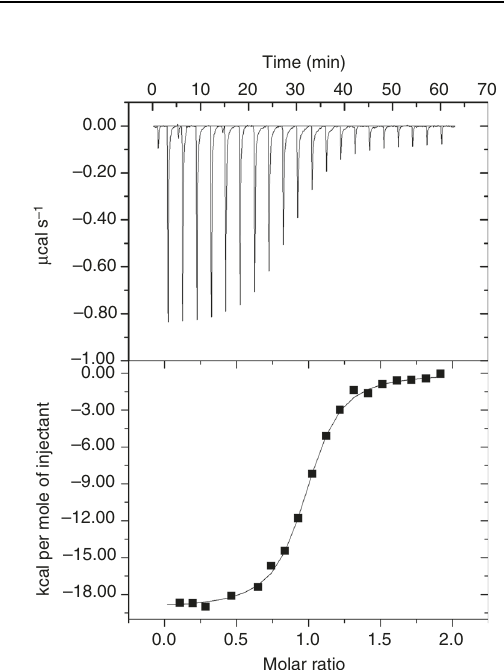
Fig. 5 Isothermal calorimetric titration of E9 endonuclease by an Im2 mutant. Shown is a representative experiment in which wild-type E9 endonuclease was titrated with the Asn34 → Ala mutant of the Im2 immunity protein. The titration was carried out in 250mM ethylenediammonium diacetate buffer (pH 7.0) at 25 °C as described under “ Methods ”